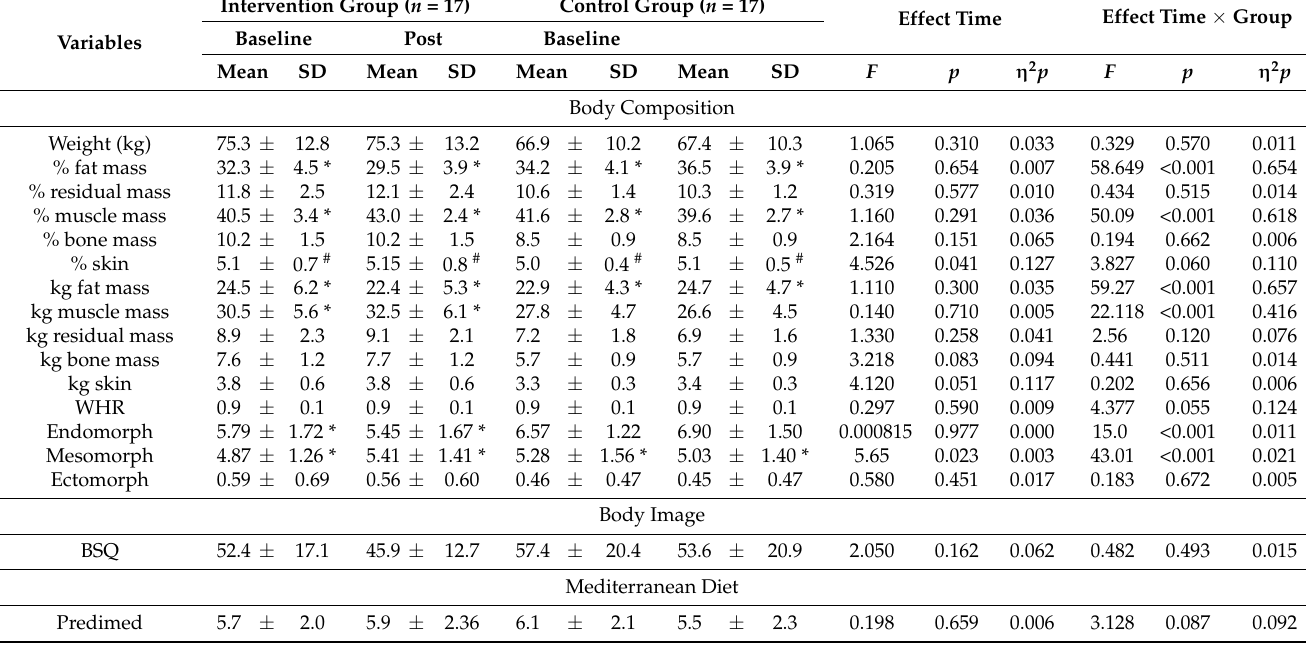
Table 2. Comparison of characteristics at baseline and post-intervention